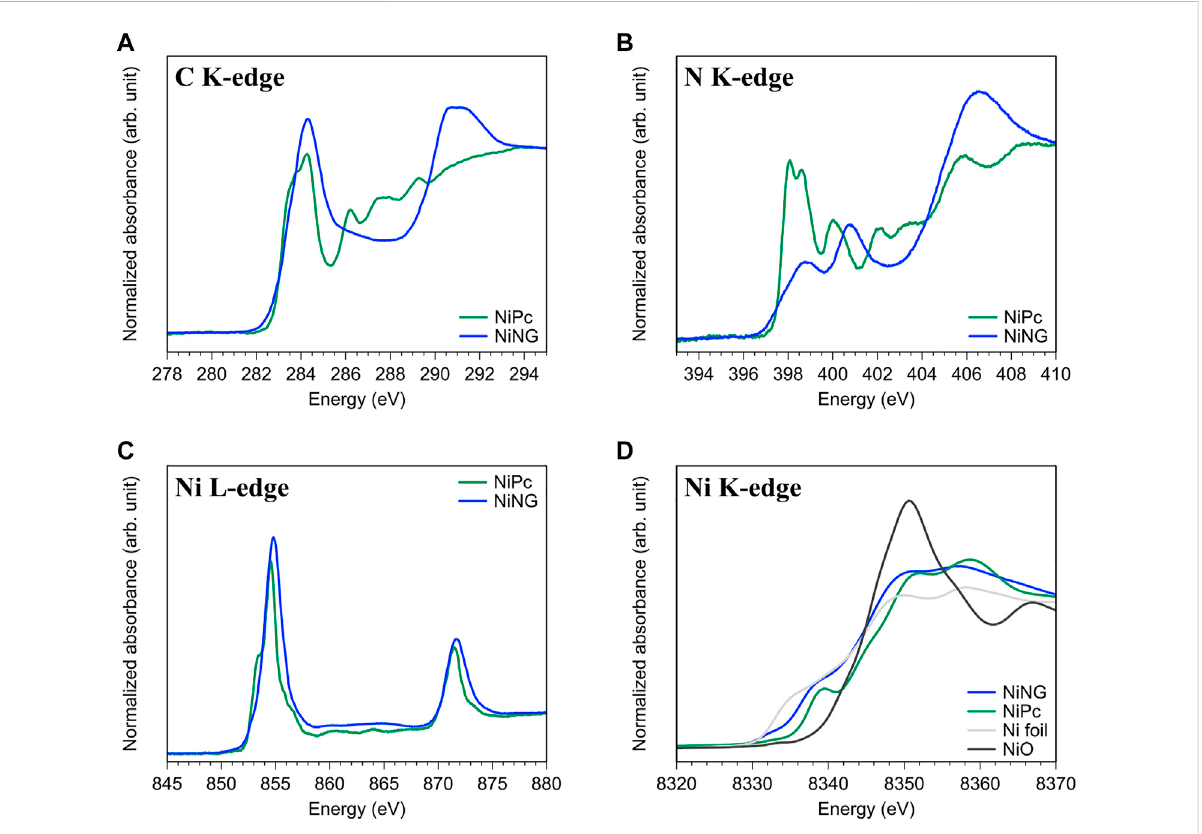
while the highest partial current density achieves at the overpotential of 0.881 V (Figure 3E). Tafel slope of